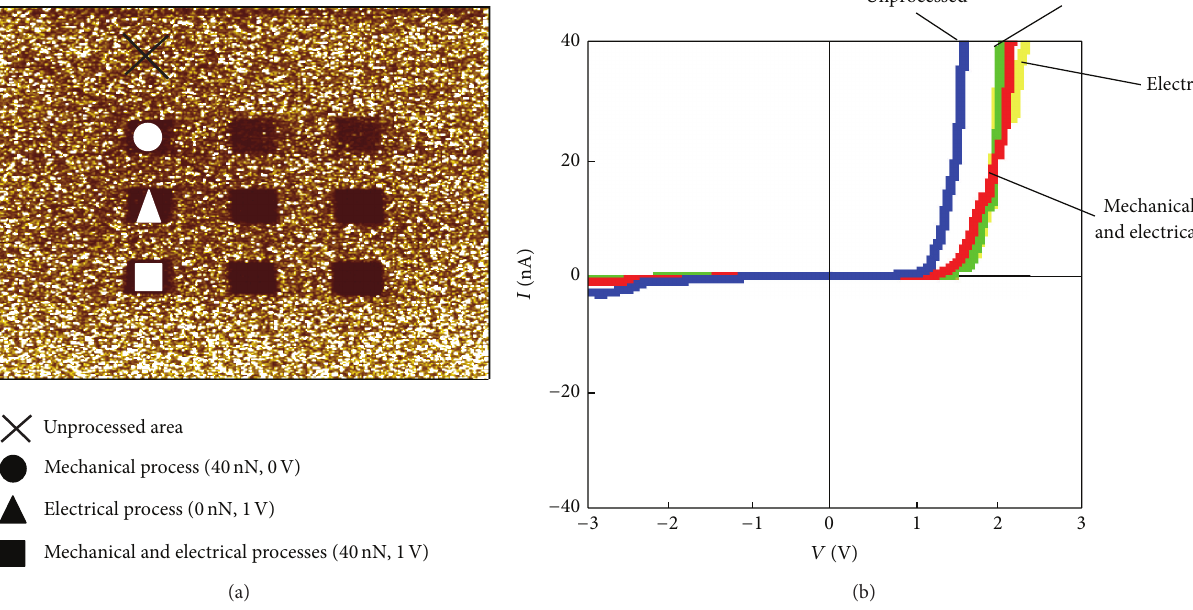
Figure 22: Surface morphology and I-V characteristics of areas processed at different loads and voltages of (closed circle) 40nN, 0 V, (closed triangle) 0 nN, 1 V, and (closed square) 40nN,